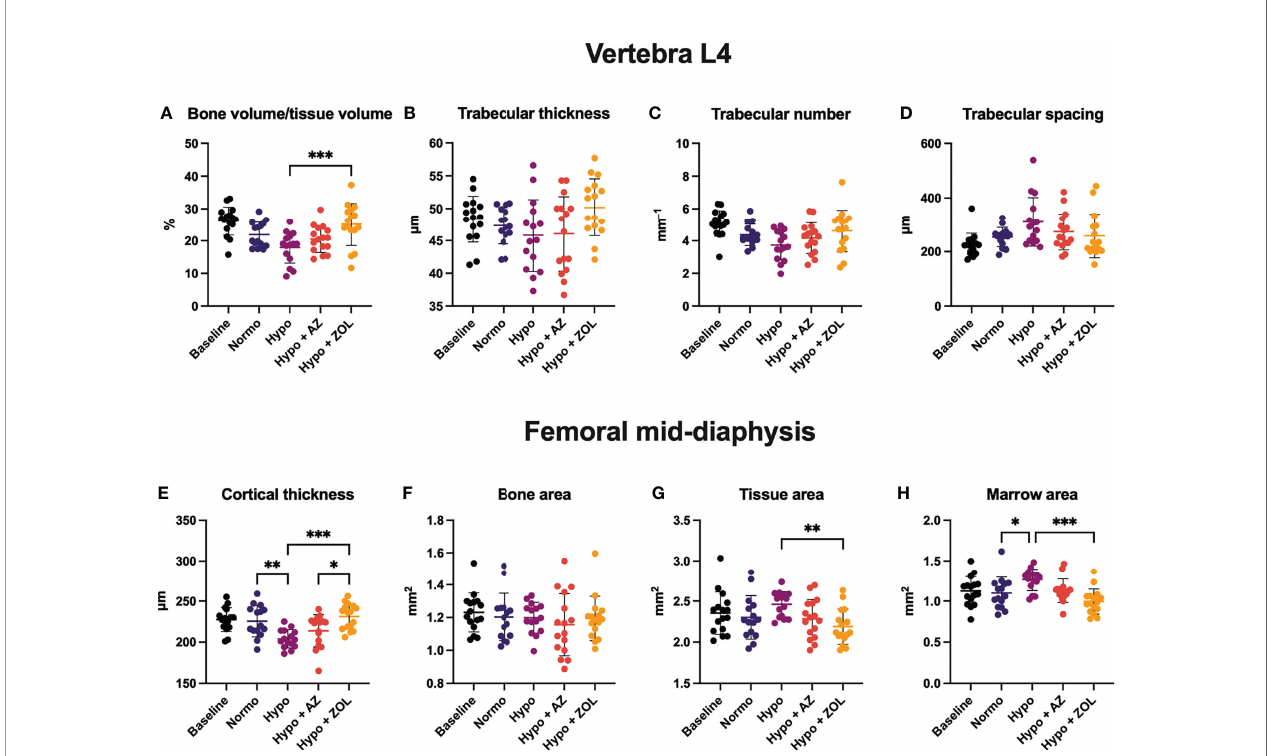
FIGURE 4 | Trabecular microstructure (A – D) and cortical morphology (E – H) of mice housed at normobaric ambient pressure (Normo) or hypobaric pressure (Hypo) at 500 mbar for four weeks and treated with acetazolamide (AZ) or zoledronate (ZOL). All data were analyzed using a one-way ANOVA, except for L4 trabecular spacing and femoral mid-diaphyseal bone area and marrow area where the non-parametric Kruskal – Wallis test were used. Data are presented as mean ± SD and n = 15 – 16/group. *p < 0.05, **p < 0.01, and ***p <